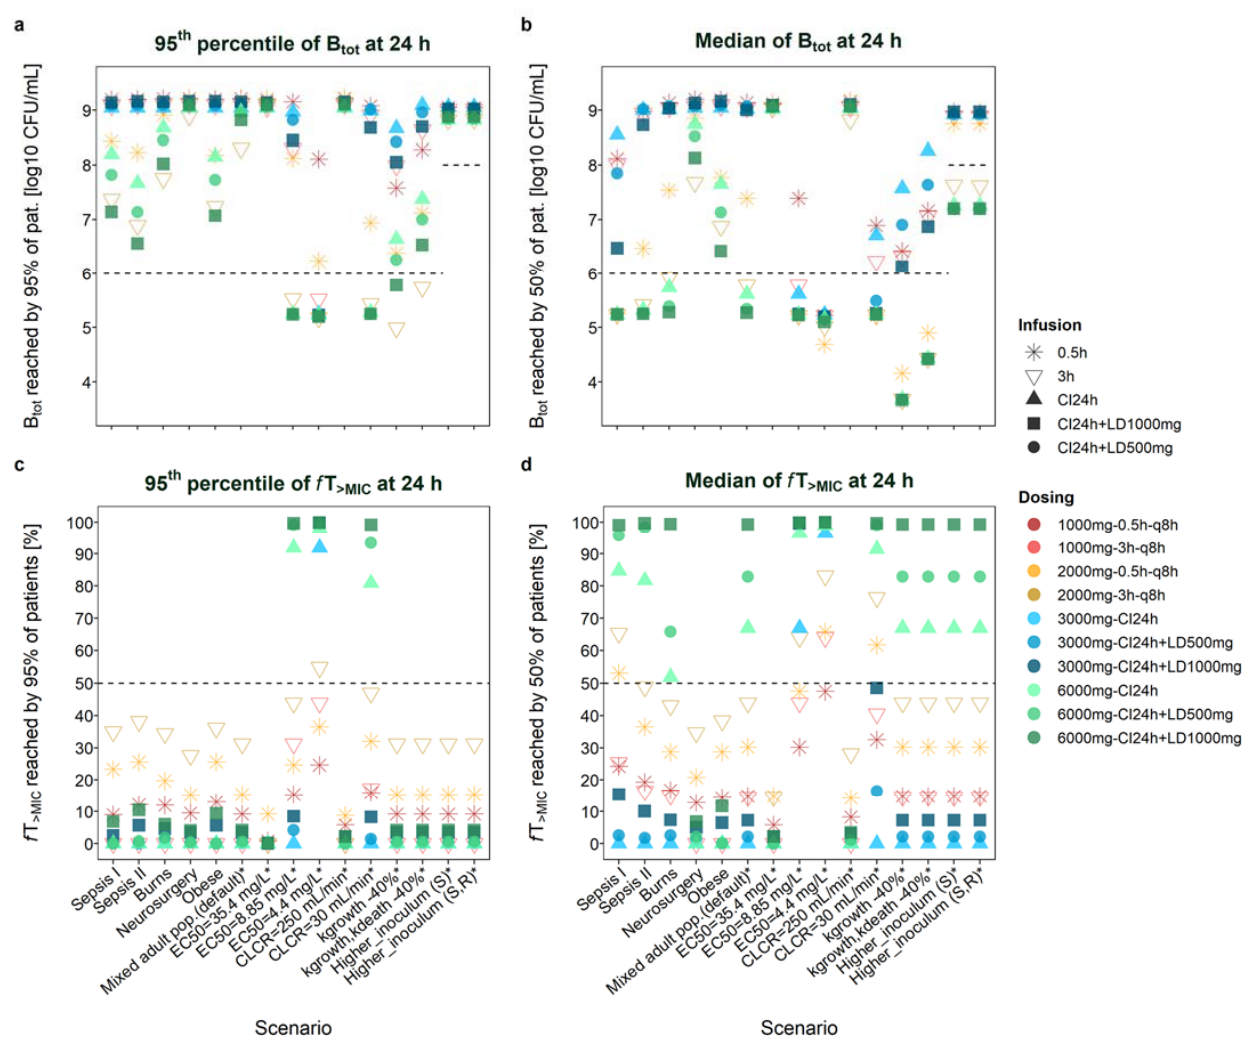
Figure 1. Total bacterial load (B tot , a , b ) and f T >MIC (time that meropenem concentrations exceed the minimum inhibitory concentration, Figures c and d) reached by 95% ( a , c ) or 50% ( b , d ) of the patient (pat.) population at 24 h after start of therapy given different scenarios. Sepsis I: Delattre et al. [23]; Sepsis II: Roberts et al. [22] (no renal dysfunction); EC 50 : drug concentration that produces 50% of E max (maximum achievable kill rate constant); CLCR: creatinine clearance; kgrowth: rate constant of bacterial growth; kdeath: rate constant of natural bacterial death; higher inoculum: initial bacterial load of 8 log10 CFU/mL, either assumed to be susceptible or with an initial fraction in the resting state; scenarios marked with an asterisk * refer to a mixed adult population (default scenario; Li et al. [21]); CI: continuous infusion; LD: loading dose; q8h: every 8 h. Most Favourable Regimens